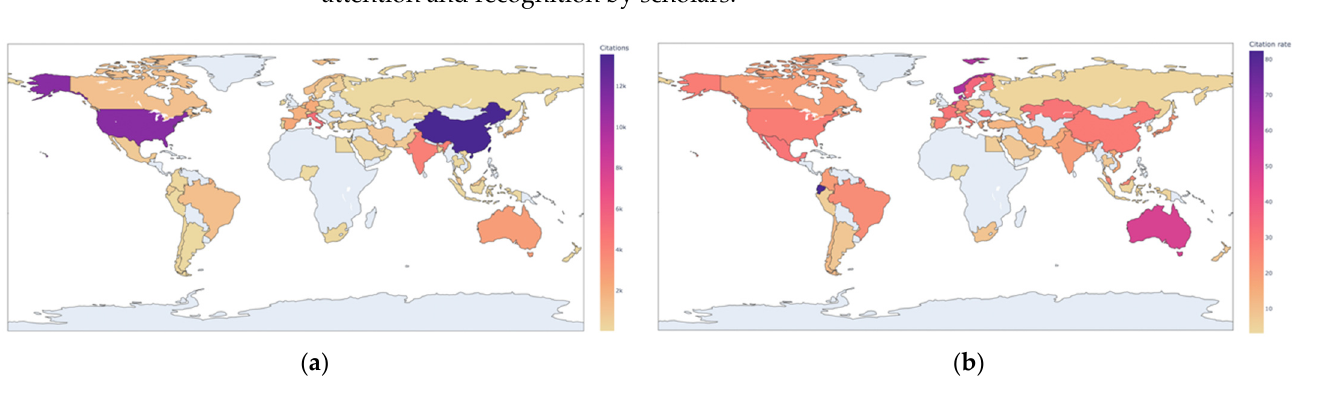
Figure 4. ( a ) The total number of citations by country; ( b ) The average citation rate by country.